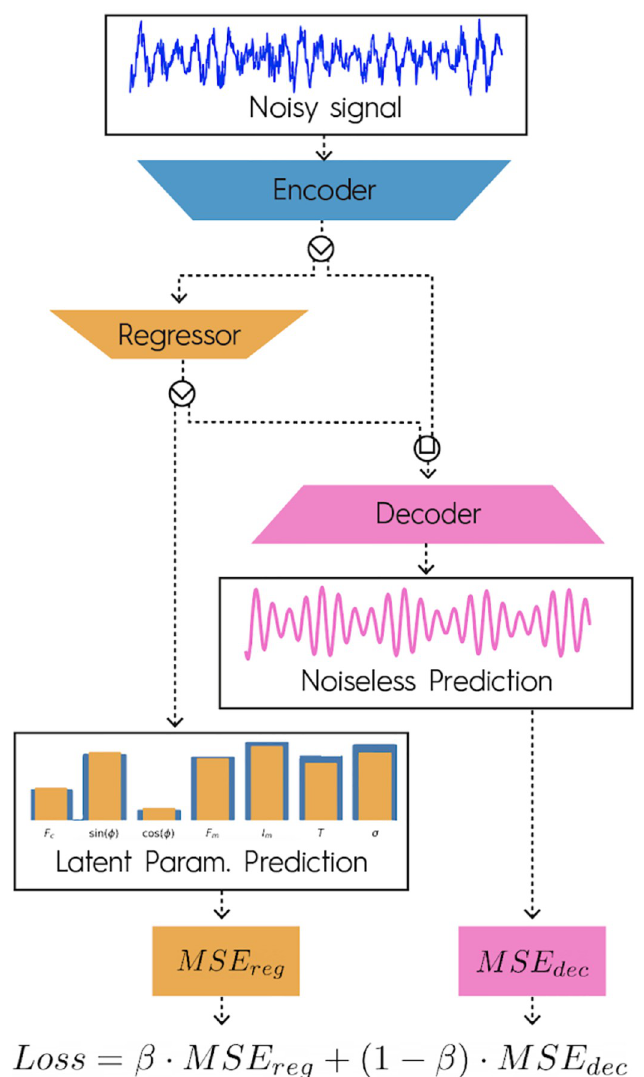
Fig 2. Unified DNN architecture and loss description. The Encoder produces a reduced representation of the input noisy signals. The Encoder output is passed to the Regressor , which outputs the latent parameters’ prediction. The Encoder and Regressor outputs are passed to the Decoder , which produces a noiseless prediction of the inputs. The Regressor and Decoder outputs are used to compute the regression and denoising losses, MSE reg and MSE dec , respectively. The loss used during backpropagation is a weighted sum of MSE reg and MSE dec using a bias parameter β